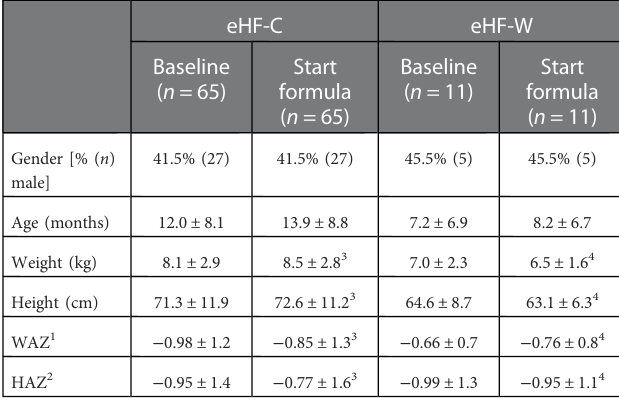
TABLE 2 Characteristics at baseline ( fi rst visit to PIs) and at start study formula consumption for both formulas.